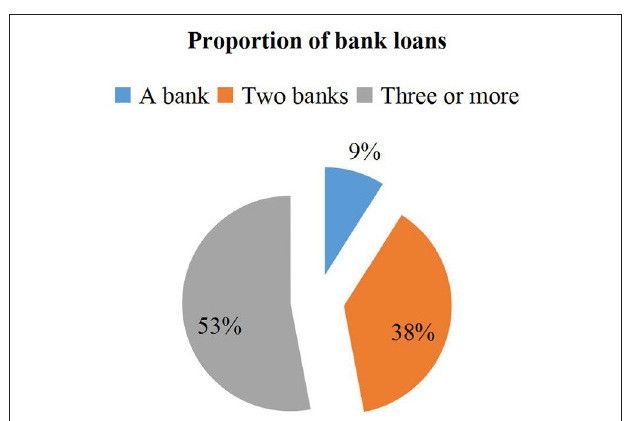
FIGURE 4 | Proportion of bank loans of